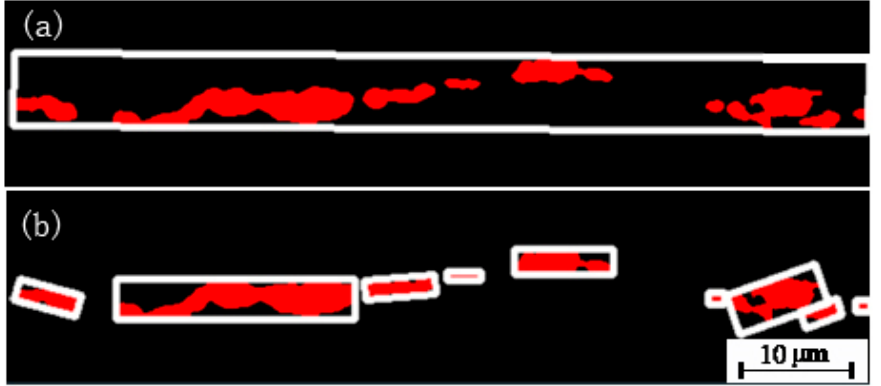
Figure 7. Establishing the length ( a ) and width ( b ) by forming the minimum bounding rectangle.